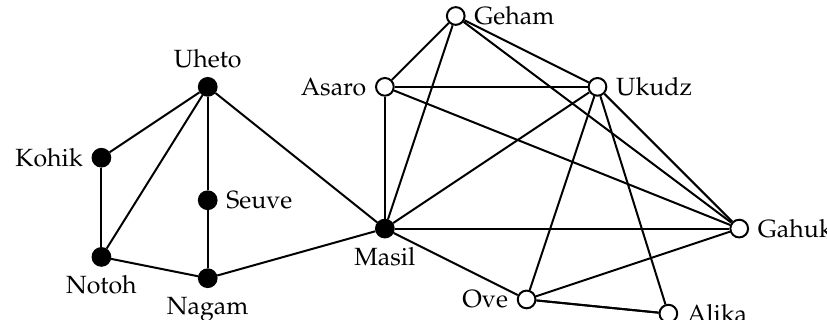
Figure 3. A part of the highland tribes social network [4]. The black vertices form a maximal 2-club. The maximum 2-club consists of Masil and all of its